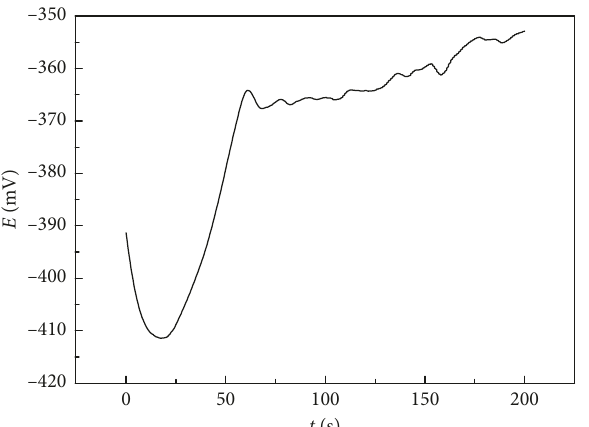
Figure 3: Corrosion potential of the oxidized 2205 in the electrolytes as a function of the pickling time at 80 ° C (containing 110g/L HCl).